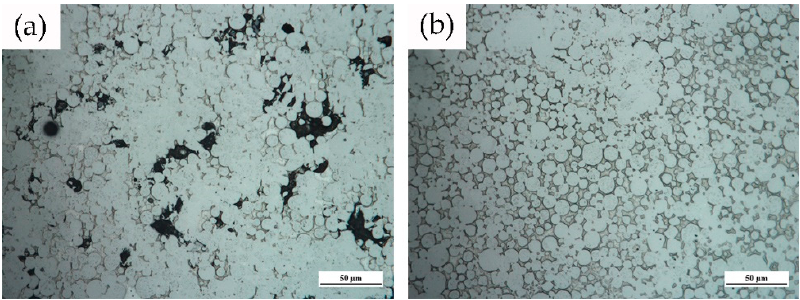
Figure 8. Transverse morphology with a high magnification. ( a ) 253.97 J/mm 3 ; ( b ) 648.15 J/mm 3 .